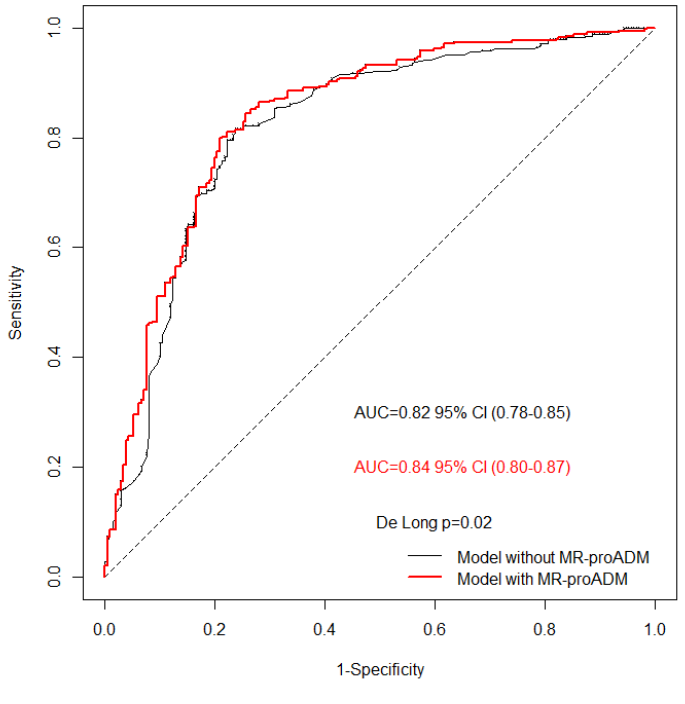
Figure 2. ( a ) The nomogram to predict culture-negative status among definitively diagnosed septic patients. List of abbreviations: LRTI = lower respiratory tract infection and MR-proADM = mid-regional proadrenomedullin. Its ROC curve and AUROC are available in Figure 2b. ( b ) Performance of the nomogram with or without mid-regional proadrenomedullin (MR-proADM) to predict culture- negative sepsis: receiver operating characteristic curves (ROC) and area under ROC curves (AUC).